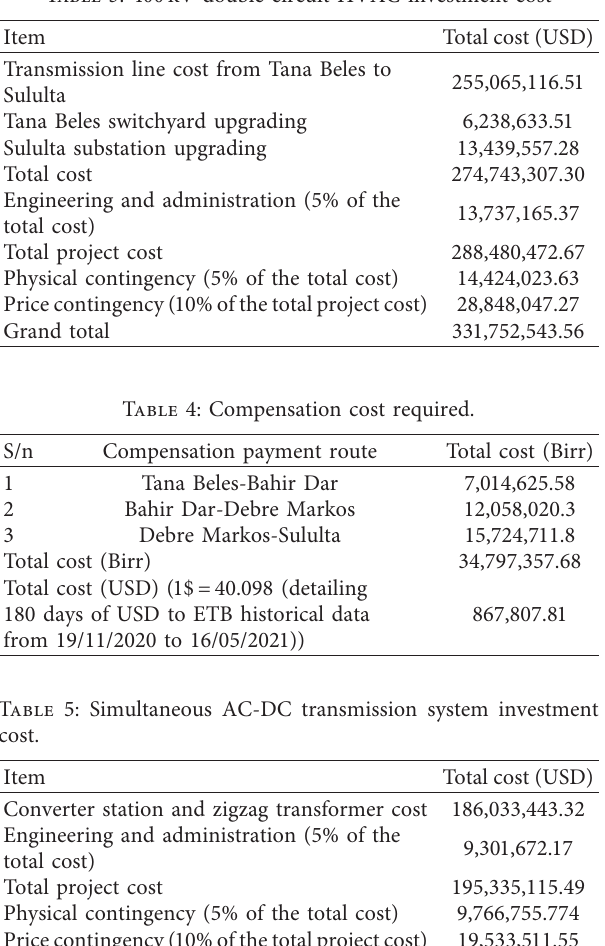
Table 3: 400kV double circuit HVAC investment cost